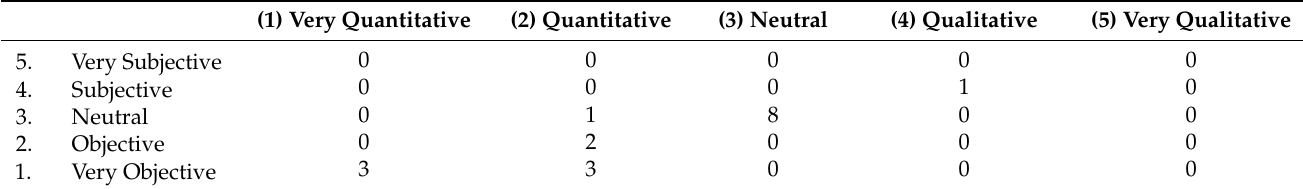
Table 4. Author 2 sources (18 sources).